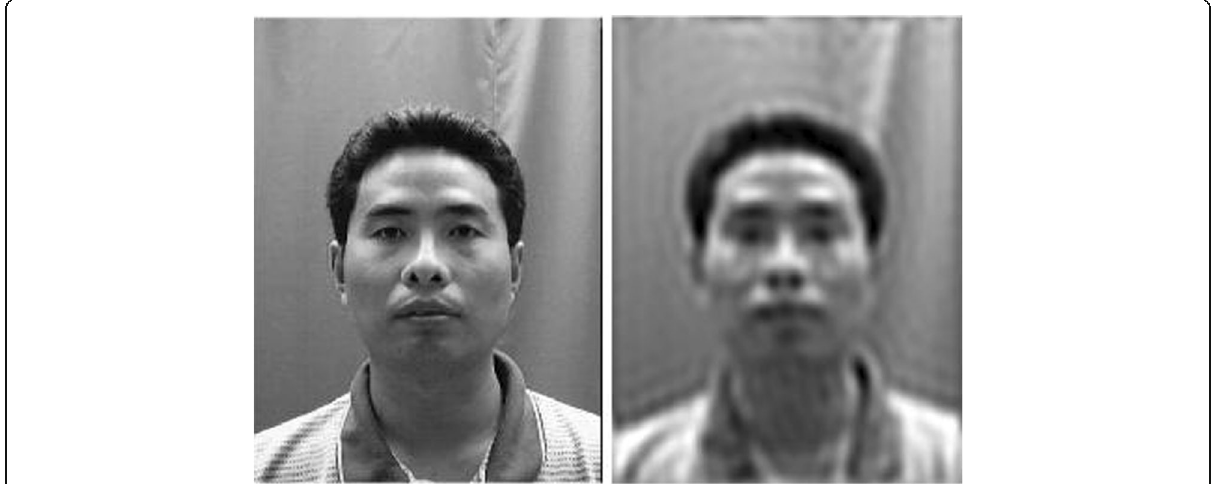
Fig. 1 The original picture and the low frequency part after wavelet